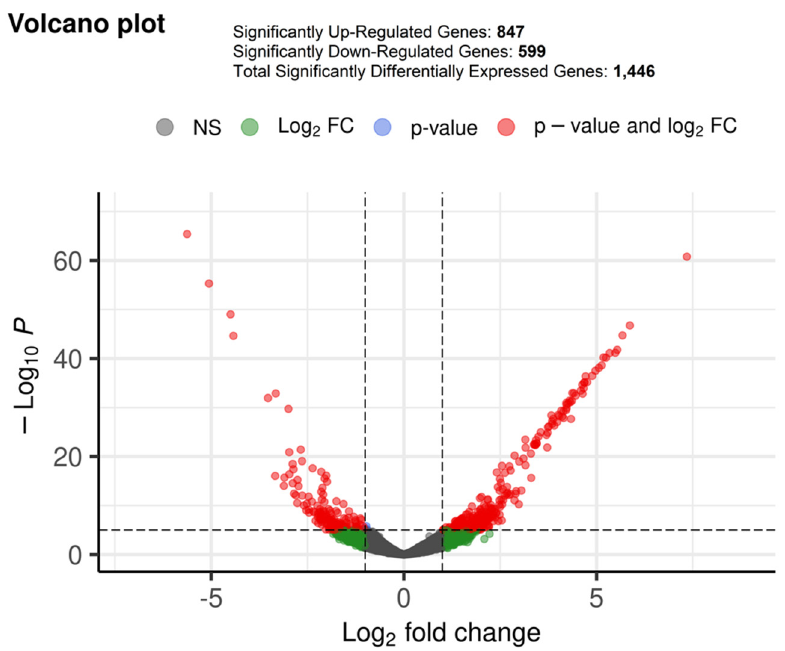
Figure 1. The volcano plot depicts the differentially expressed genes in breast cancer patients resistant to chemotherapy treatment.